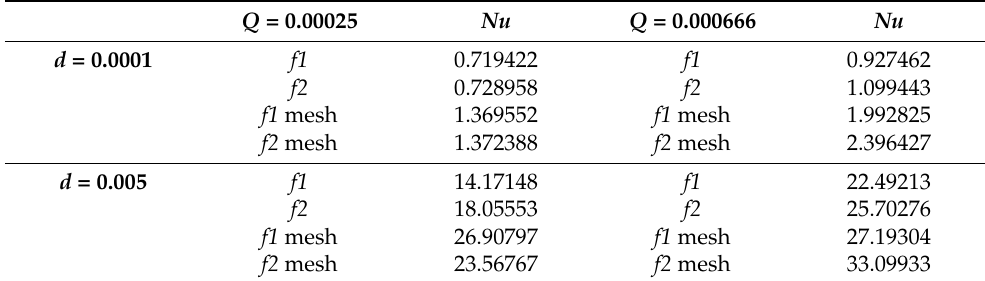
Figure 9. Heat transfer coefficient Nu , d = 100 µm: ( a ) Q = 0.00025 m 3 /s; ( b ) Q = 0.000666 m 3 /s. The average values of the heat transfer coefficient Nu are summarized in Table 2. Table 2. The average values of the heat transfer coefficient Nu.